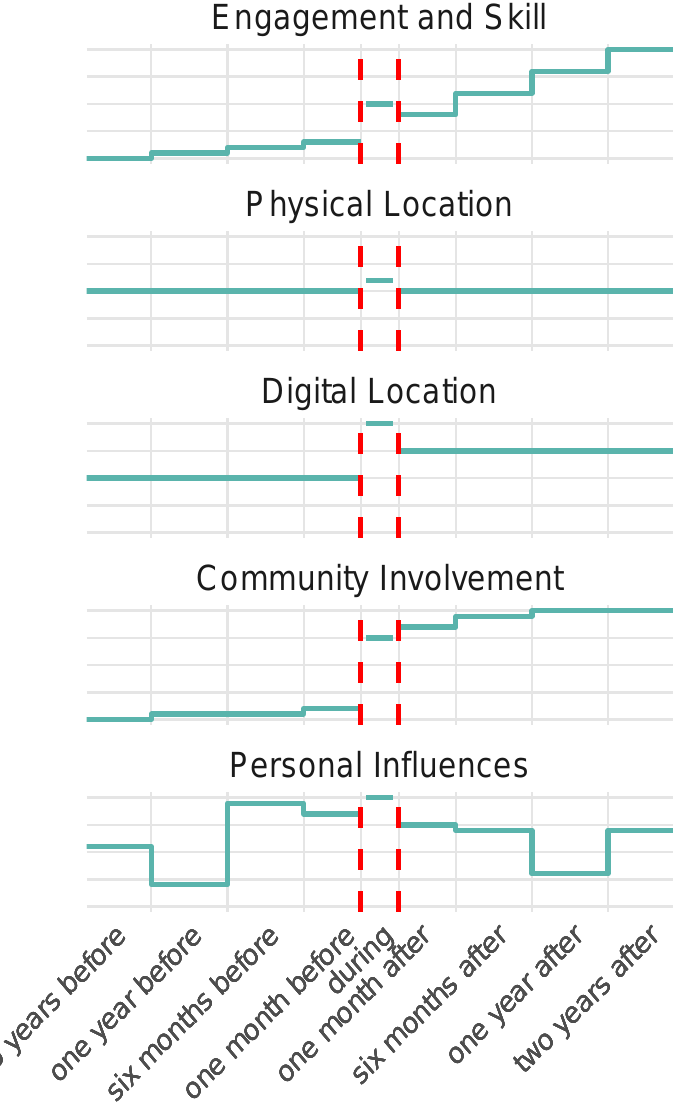
Figure 3. A hypothetical trajectory of mapping behaviour of a model mapper taking part in a happening along the five abstract dimensions of contextual effects. The x-axis represents different time intervals before, during, and after the happening. In this example, the mapper always contributed from the same place (physical location) but her engagement and skill, as well as her community involvement, rose over time and especially after the event. The personal influence seems to be somehow random while her digital location changed through the event. During the event, the mapper diverges from her usual